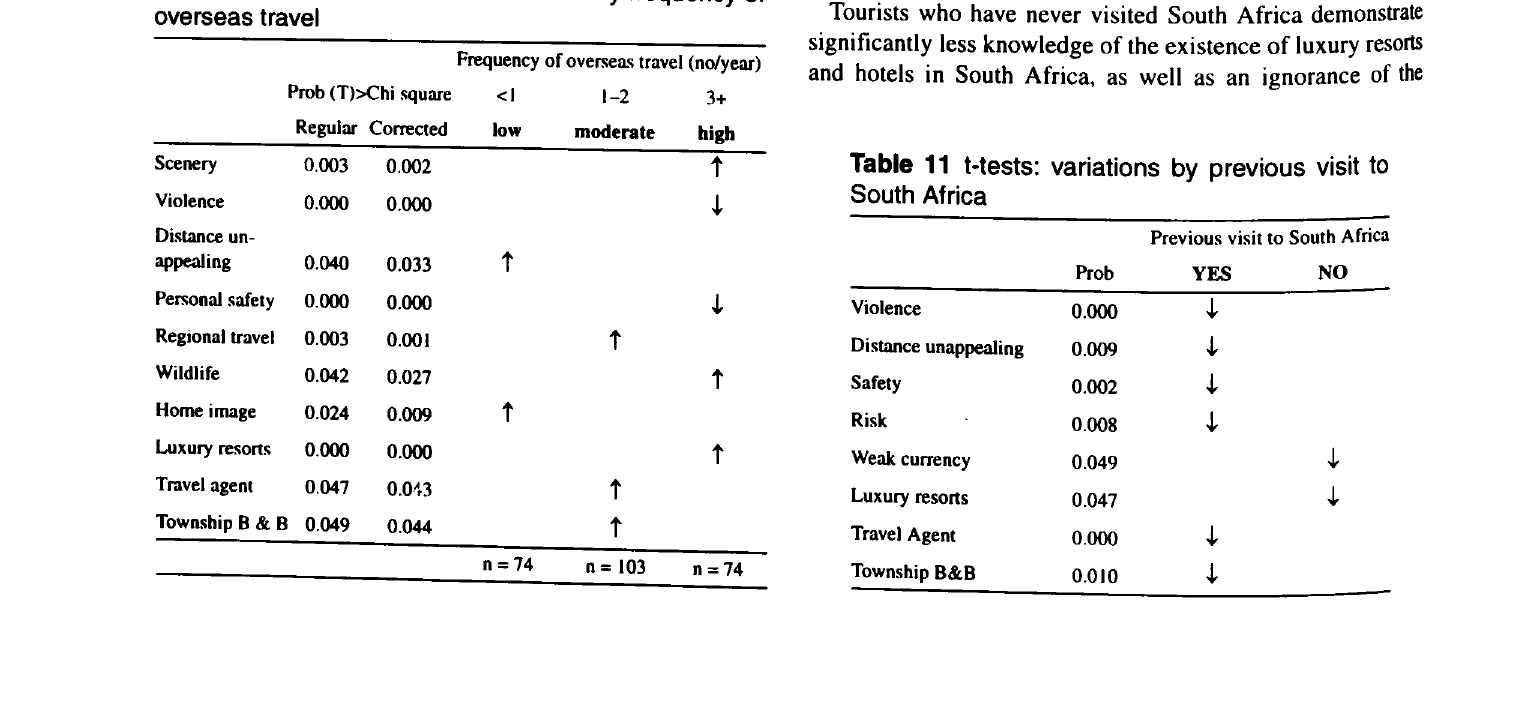
Table 10 Kruskal-Wallis test: variations by frequency